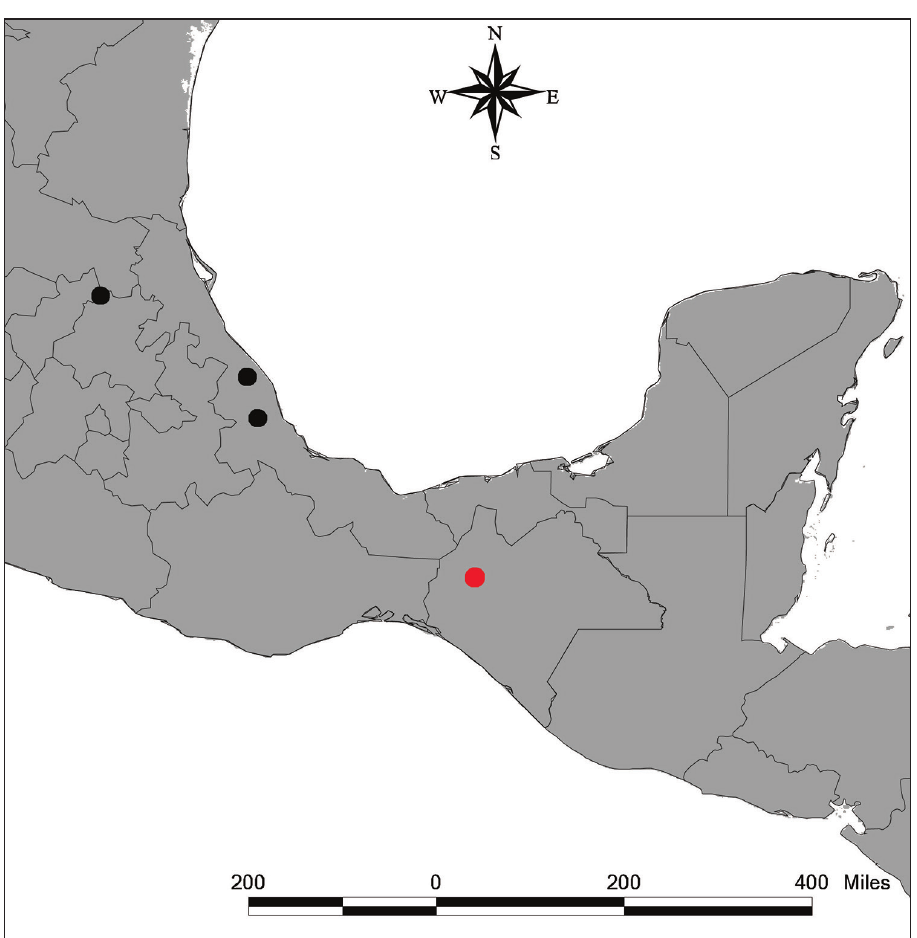
Figure 1. Distribution range of Tridimeris chiapensis Escobar-Castellanos & Ortiz-Rodr. (red dot) and Tridimeris hahniana Baill (black